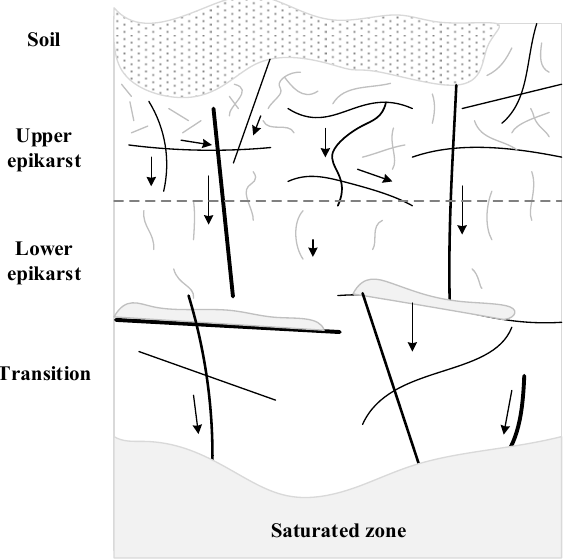
Figure 6. Schematic representation of vertical hierarchical structure for karst system (modified from Perrin et al. [11]). Water 2020 , 12 , x FOR PEER REVIEW Table 2. Equivalent soil moisture movement parameters in karst system.